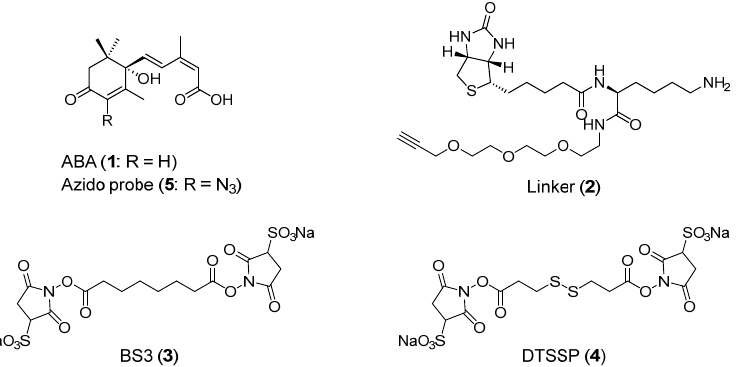
Figure 1. Compounds in this study. BS3: bis(sulfosuccinimidyl)suberate disodium salt; DTSSP: dithiobis(sulfosuccinimidyl propionate) disodium salt.